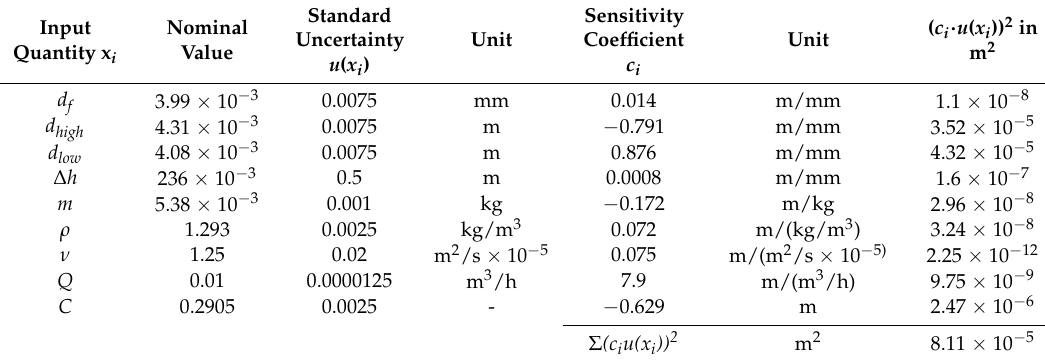
Table A2. Uncertainty budget for VA meter (3–30) dm 3